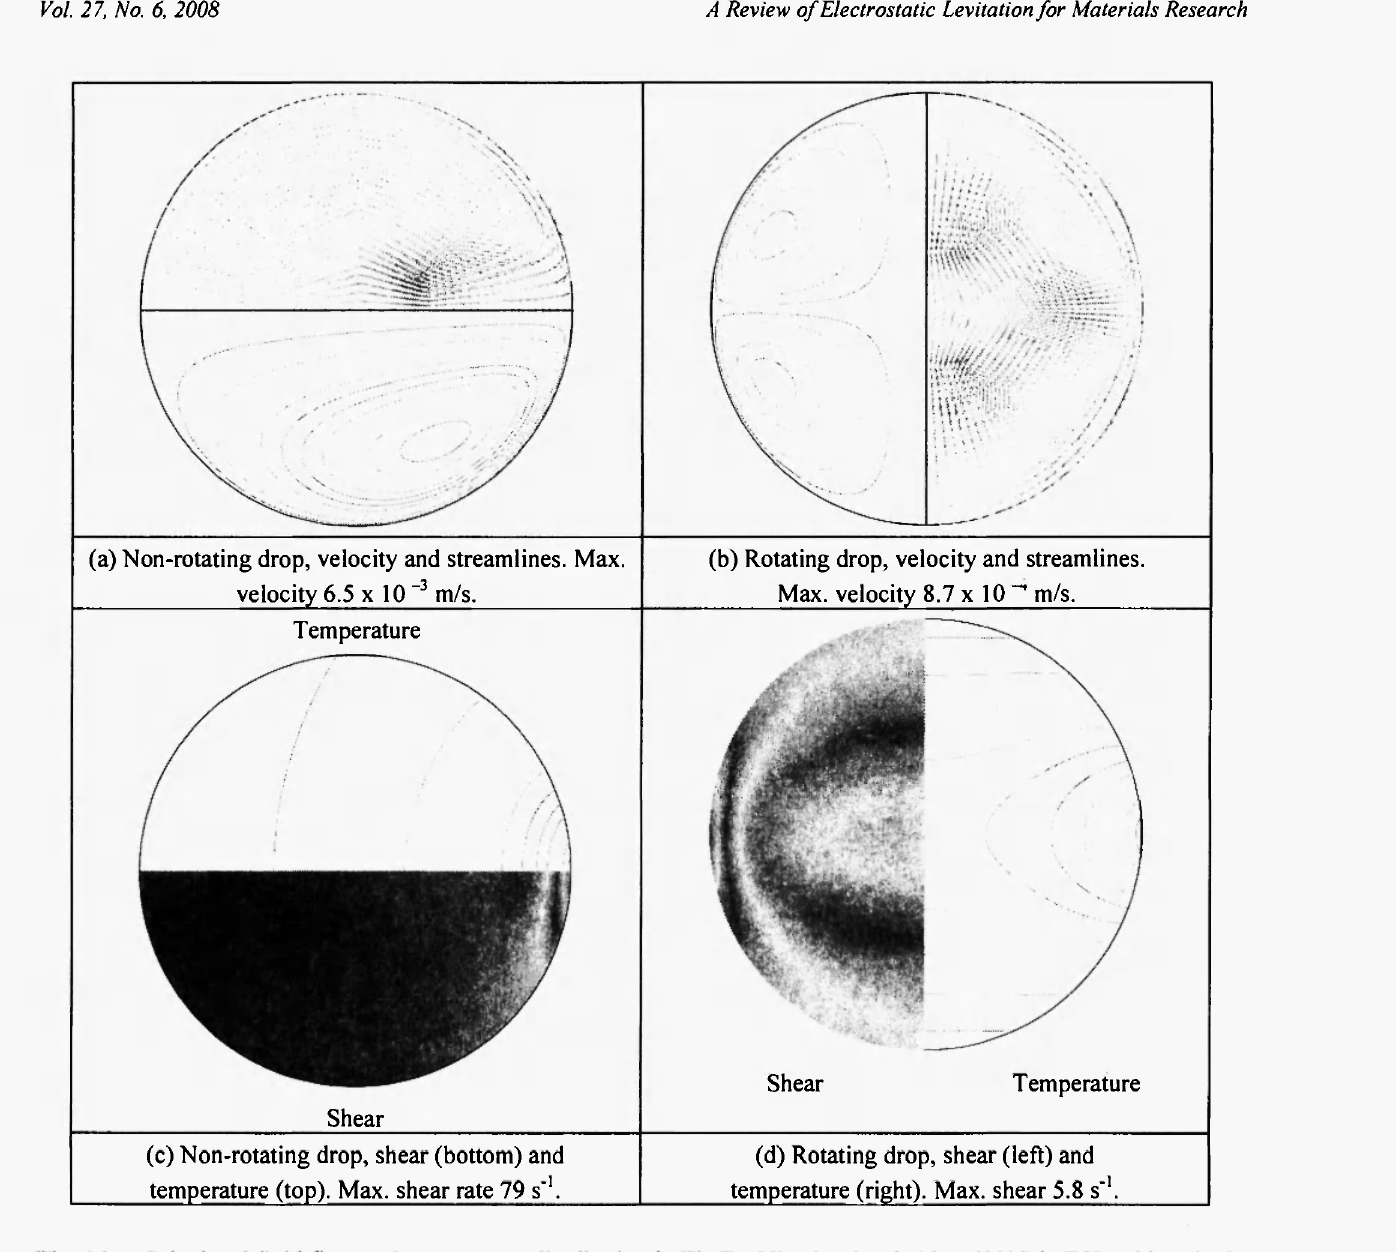
(c) Non-rotating drop, shear (bottom) and (d) Rotating drop, shear (left) and temperature (top). Max. shear rate 79 s' 1 . temperature (right). Max. shear 5.8 s' 1 . Fig. 14: Calculated fluid flow and temperature distribution in Ti 3 7Zr 4: >Ni2i droplets held at 680°C in ESL with a single heating laser. The left figures are for a static (non-rotating), while the right figures are for a rotating